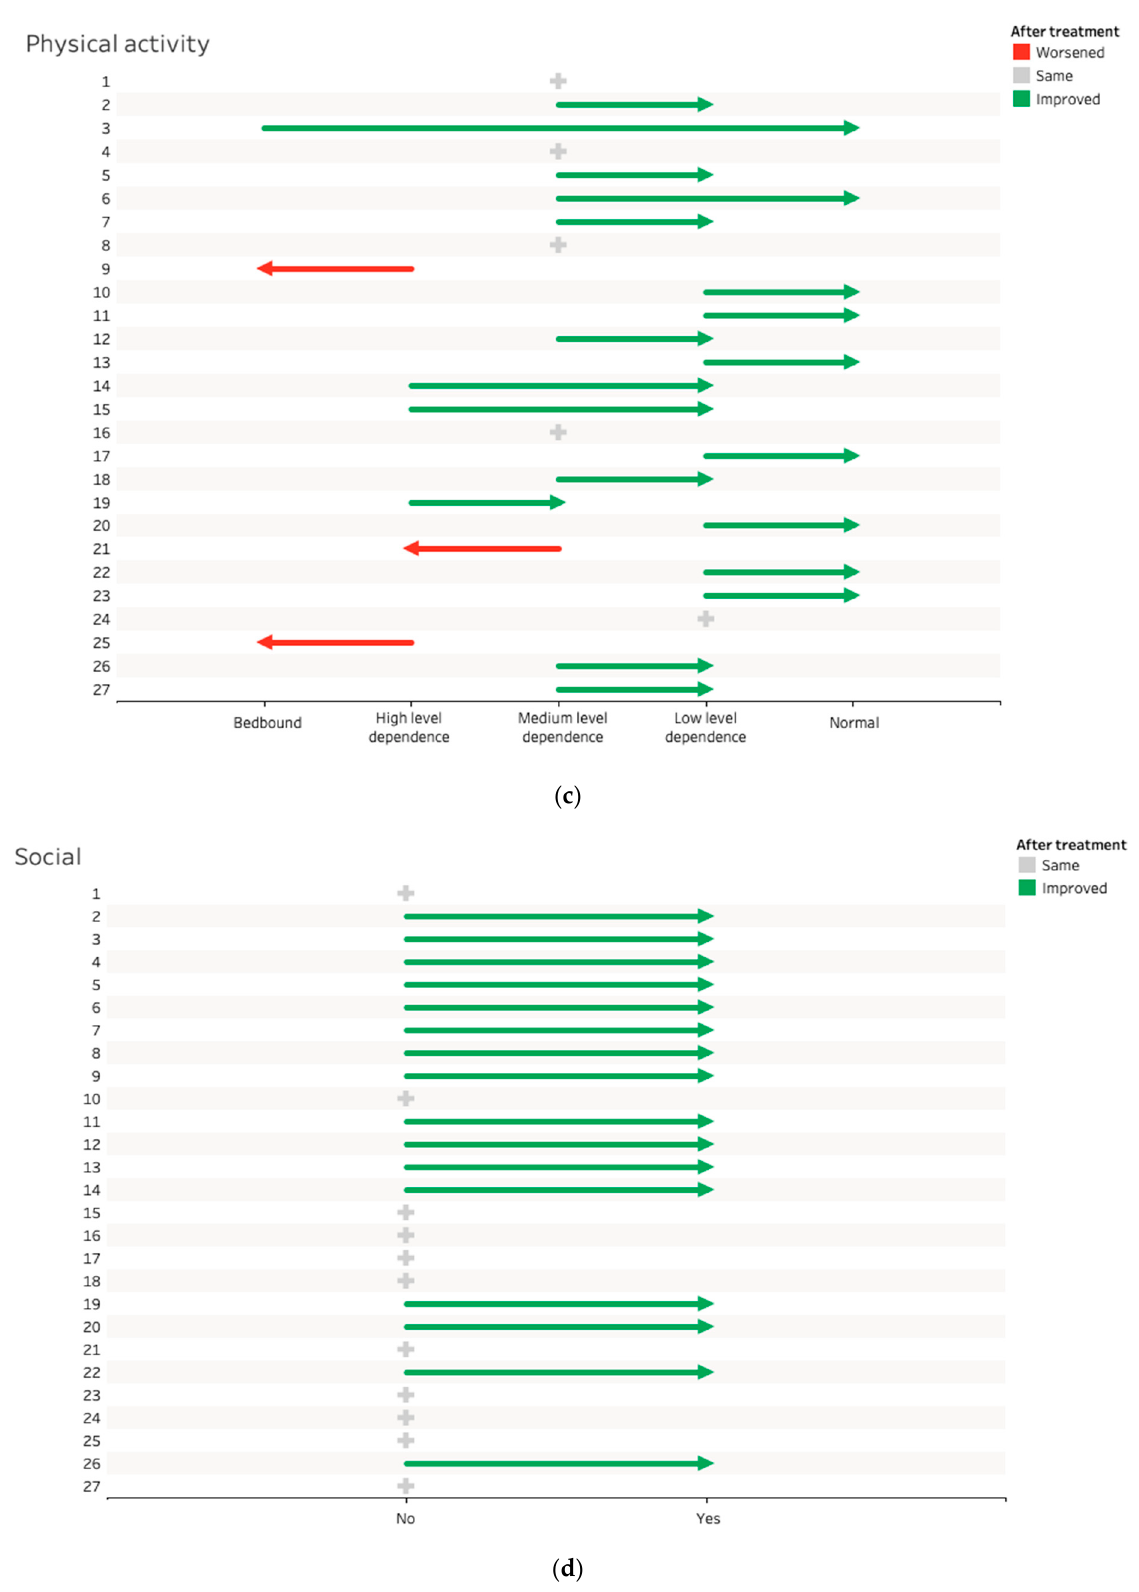
Figure 1. ( a ) Participation in education, ( b ) sleep, ( c ) participation in physical activity, ( d ) ability to socialise/take part in recreational activity.